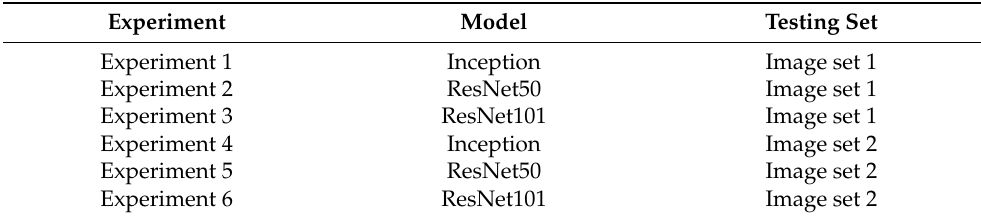
Table 4. Experiments definition for detection